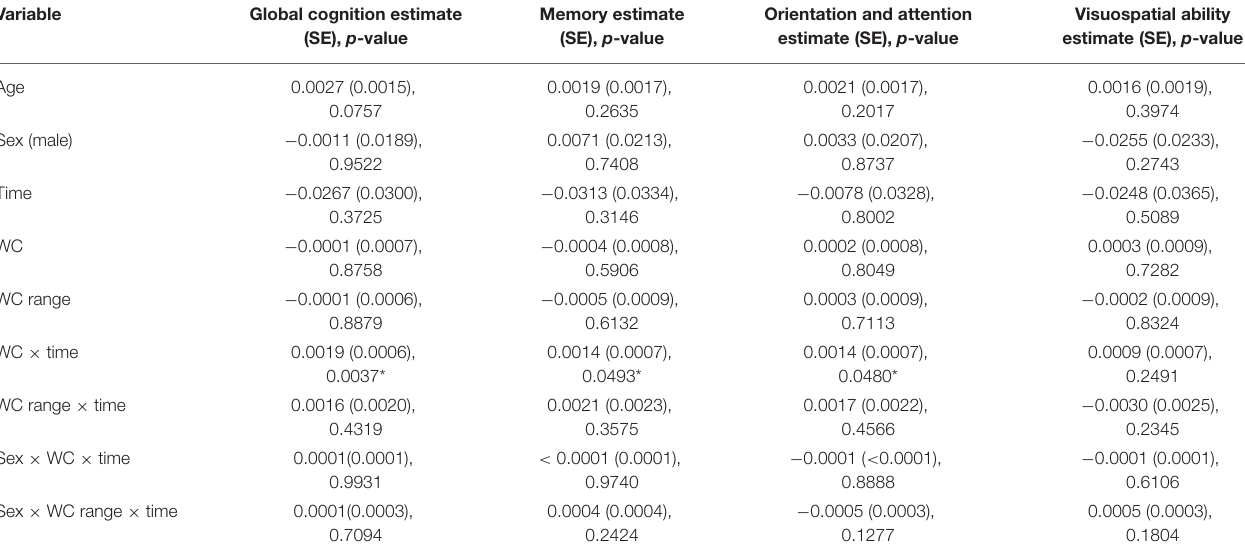
TABLE 3 | The association between waist circumference (WC), WC range, and decline among global cognition and cognitive subdomains (SD per year). Variable Global cognition estimate